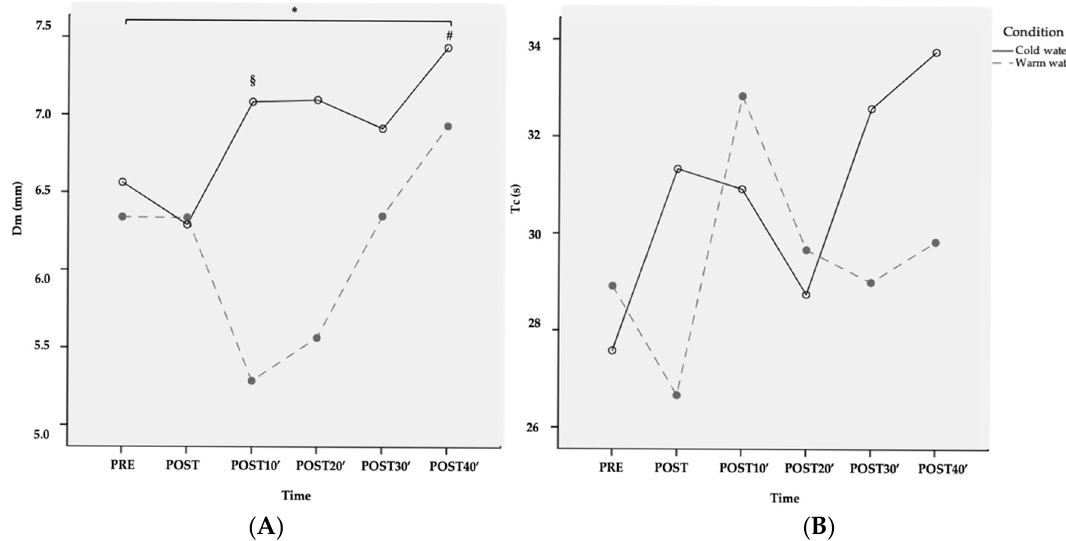
Figure 3. Changes in Dm ( A ) and Tc ( B ) after CWI and WWI (raw data - variables non-transformed). * = Significant interaction condition by time; § = Differences of cold-water condition with respect to PRE; # = Differences of warm-water condition with respect to PRE.